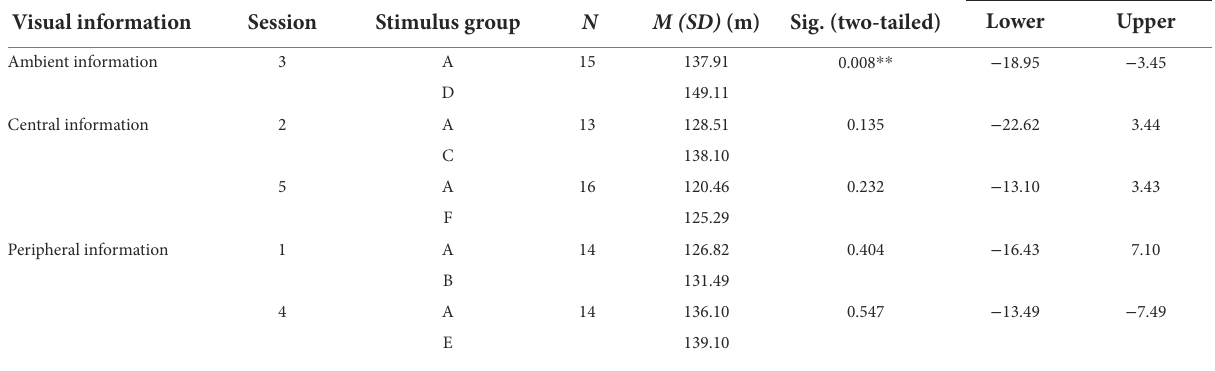
TABLE 5 Average estimated distance among the three positions in each session in Task 2.